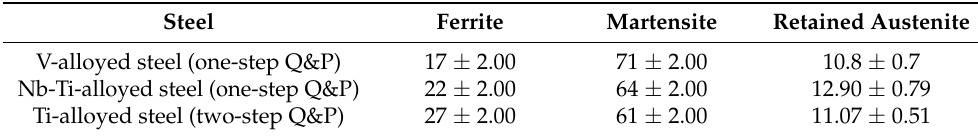
Table 2. The volume fractions of the different phases